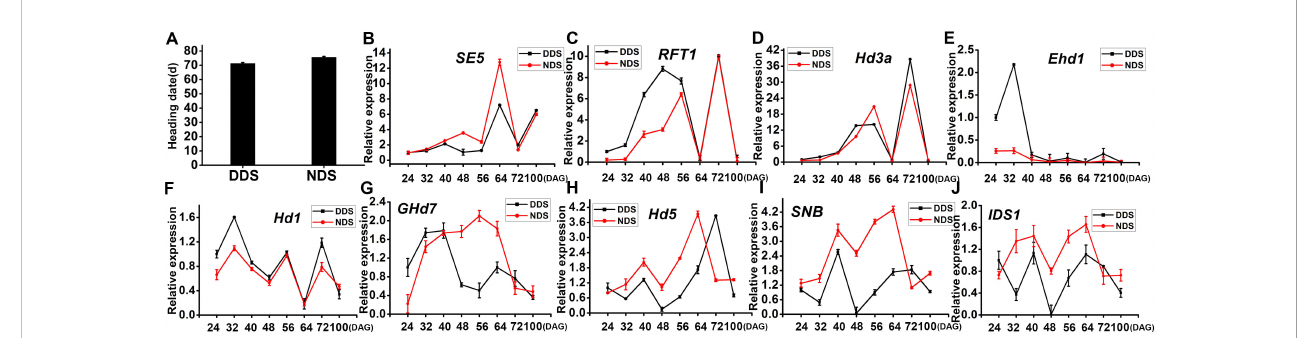
FIGURE 5 DDS showed early fl owering and HD related genes. (A) The heading dates of NDS plants were delayed by 4 d, compared with the DDS. (B-J) qRT-PCR analysis of temporal expression in the whole plant of SE5, RFT1, Hd3a, Ehd1, Hd1, Ghd7, Hd5, SNB, IDS1 between DDS and NDS at 24 、 32 、 40 、 56 、 64 、 72 、 100 DAG. Error bars represent mean ± SD (n = 3) where the different letters indicate statistical differences by Duncan ’ s multiple range test (p ≤